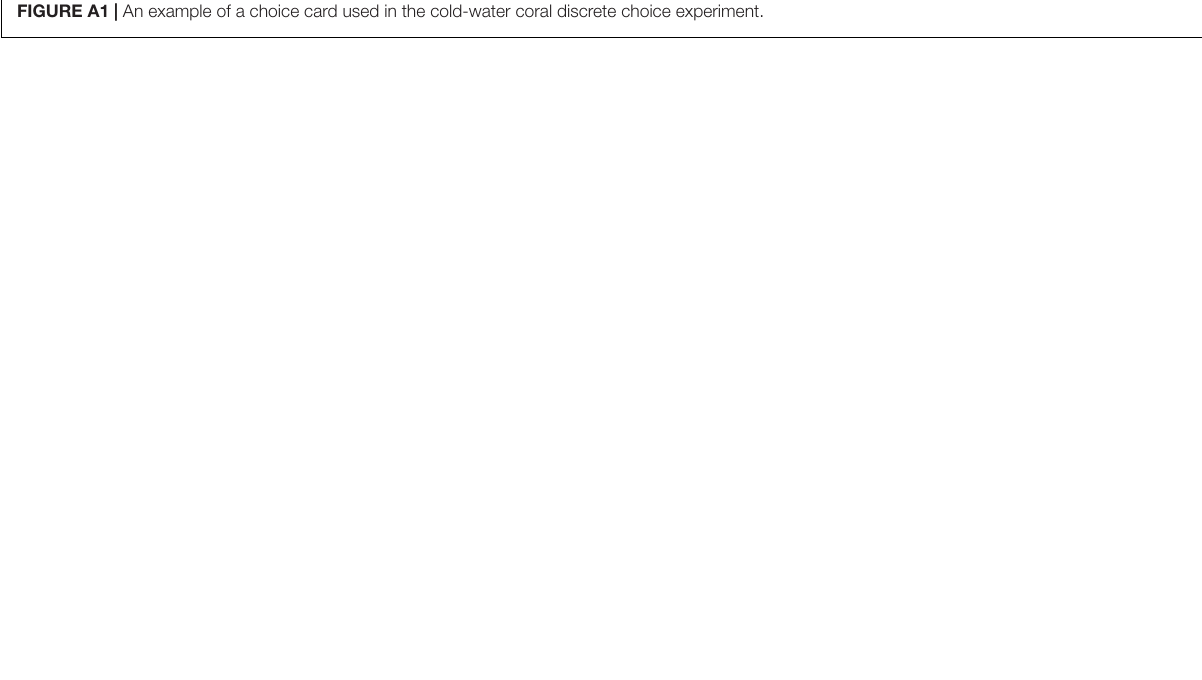
Frontiers in Marine Science |